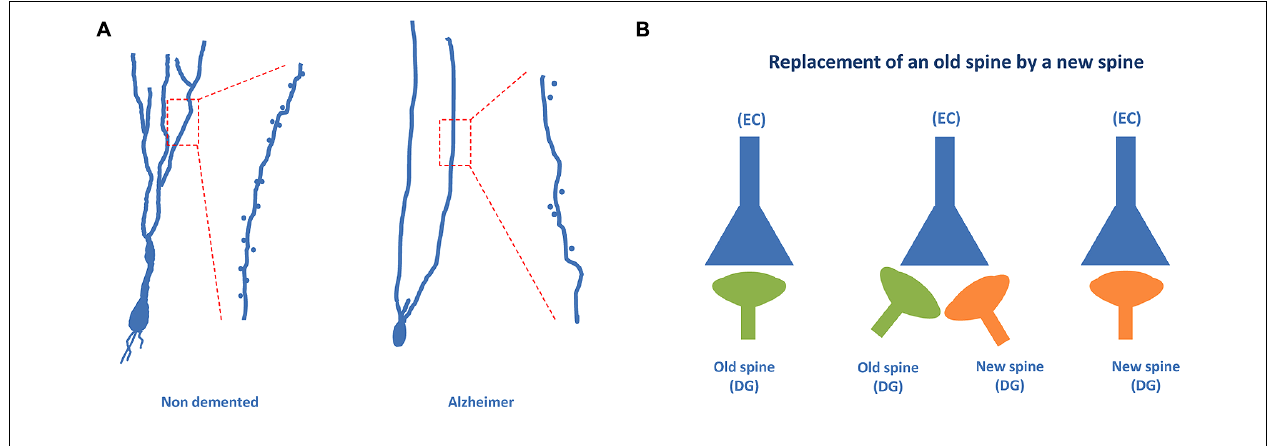
FIGURE 5 | Granule neurons of the dentate gyrus form functional synapses. In (A) , the typical “Y” shape morphology characteristic of granule neurons can be observed in the case of non-demented control cases, whereas an altered, “V” shape morphology has been described in